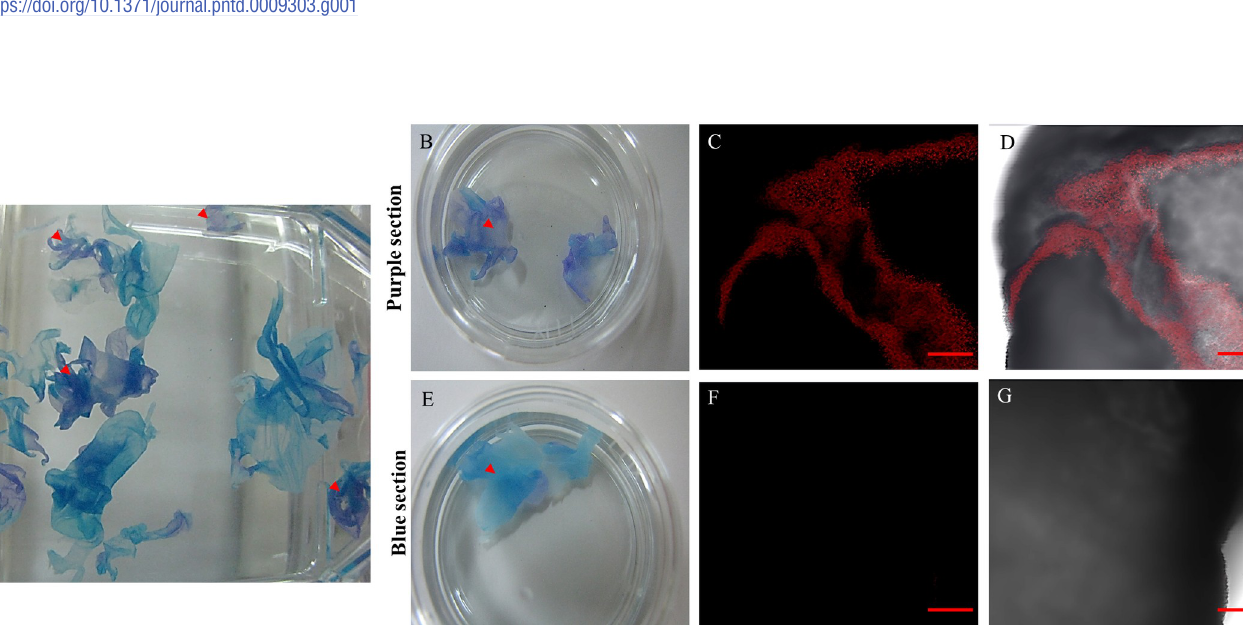
PLOS NeglectedTropical Diseases | https://doi.org/10.1371/journal.pntd.0009303 March 22,